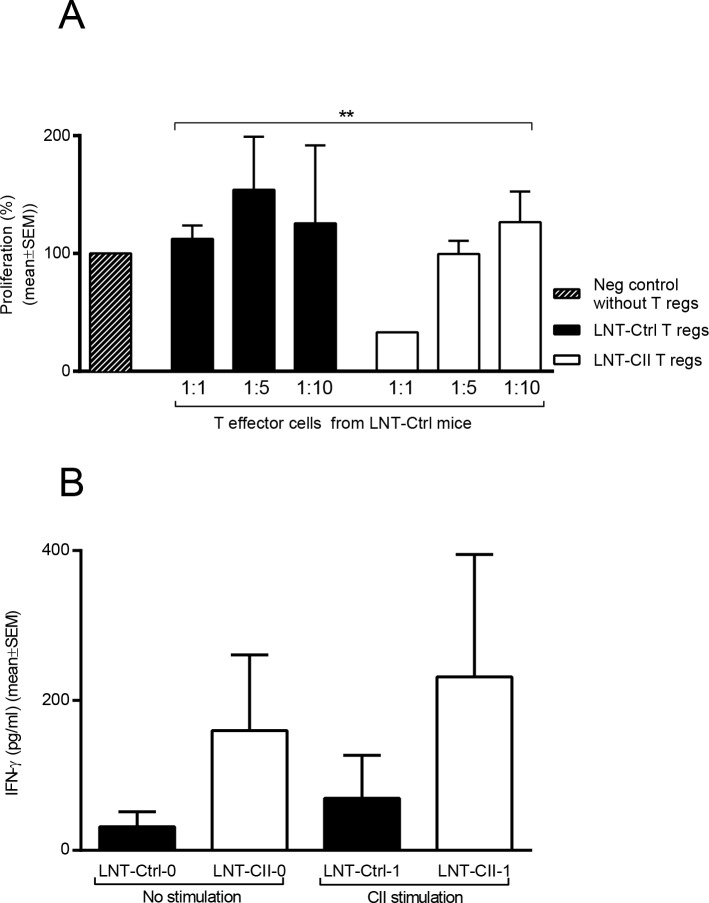
Involvement of T cells in tolerance induction.(A) Capacity of Tregs cells to down-regulate effector T cell responses. Sorted Tregs cells from LNT-Ctrl or LNT-CII mice were co-cultured with LNT-Ctrl T effector cells in ratios 1:1, 1:5 and 1:10 for three days and proliferation measured by radioactive thymidine incorporation (counts per minutes). Y-axis—percentage of proliferation compared to the negative control containing sorted T effector cells only (n = 6/group). The experiment has been repeated three times. (B) CII-specific IFN-γ production from stimulated spleen cells obtained 14 days after CII immunization, n = 4–5 and repeated once. Statistical analysis was performed using Two-way ANOVA for evaluation of proliferative responses in (A) and Mann-Whitney U-test in (B), mean±SEM.